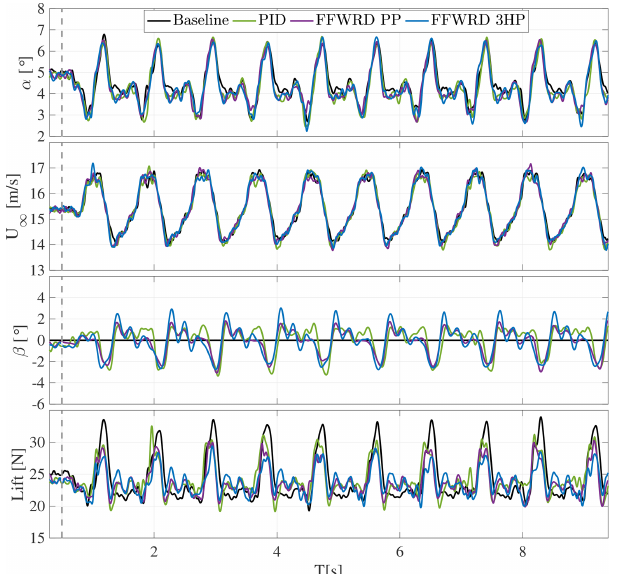
Figure 19. Time series of AoA and inflow velocity variation, flap motion, and resulting lift amplitude at a reduced frequency of k = 0 . 072 for different control methods in comparison to the un- controlled baseline case.